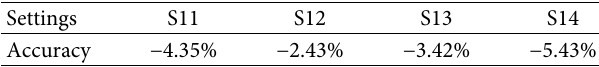
Table 3: Performance decrement ( − )/increment (+) of different algorithms on